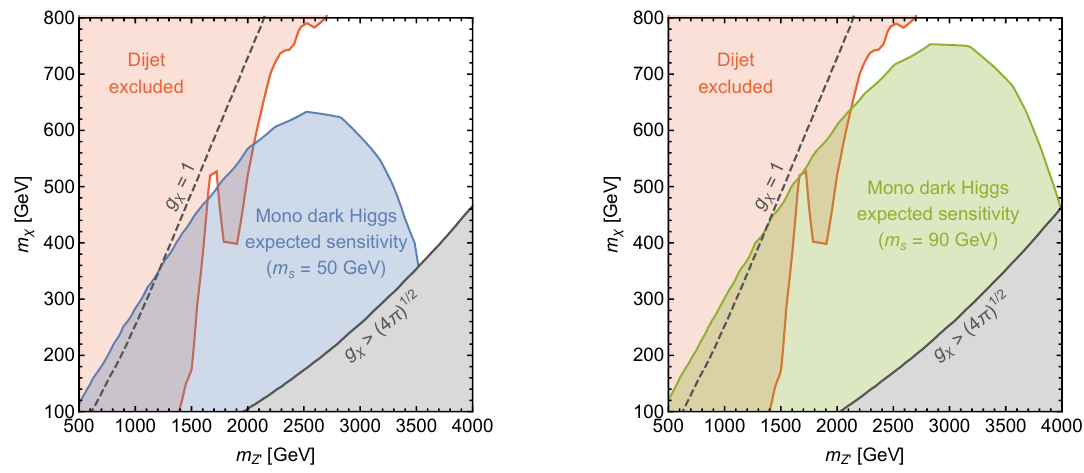
Figure 7 . Expected sensitivity of a search for dark Higgs bosons with m s = 50 GeV (left) and m s = 90 GeV (right) in the m Z 0 { m (cid:31) parameter plane for g q = 0 : 25 and under the assumption that the dark sector coupling y (cid:31) (or equivalently g (cid:31) ) is (cid:12)xed by the relic density requirement (see (cid:12)gure 6). For comparison, we show existing bounds from a search for di-jet resonances that are obtained from [94]. By construction, the line labelled g (cid:31) = 1 is identical to the one labelled (cid:10) h 2 = 0 : 12 in the left panel of (cid:12)gure